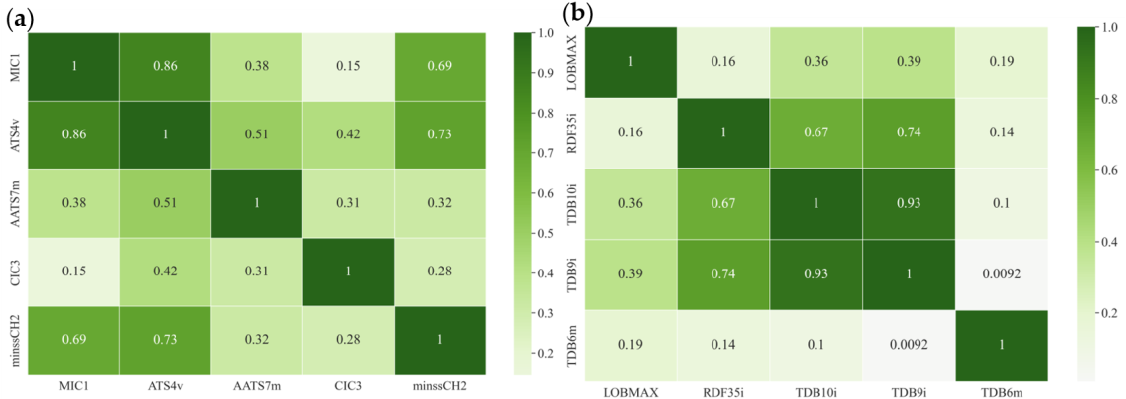
Figure 3. Optimal autocorrelation analysis in MLR − QSAR models: ( a ) 2D − QSAR model of dietary flavonoids. ( b ) 3D − QSAR model of dietary flavonoids.